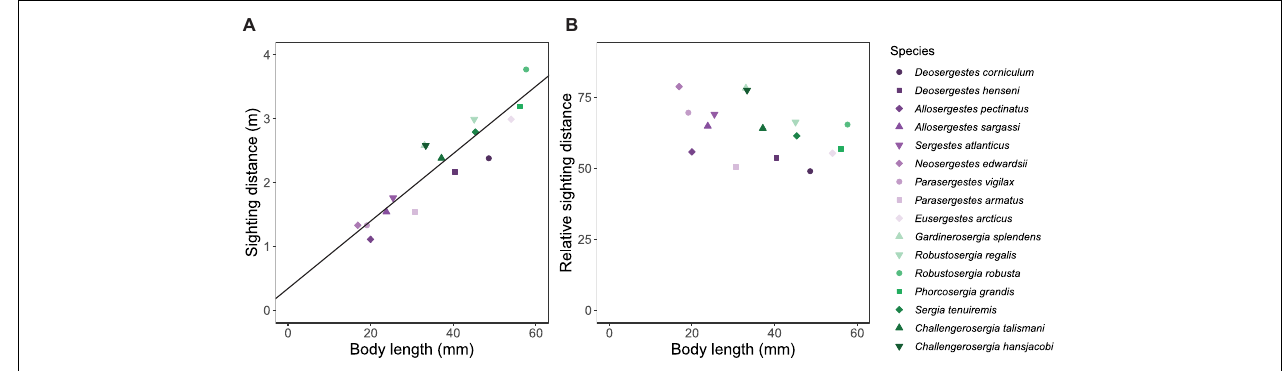
FIGURE 6 | Maximum thresholds of bioluminescence sighting distance. Plots show (A) estimated sighting distance and (B) relative sighting distance (as a factor of body lengths for a given species) vs. mean body length for -sergia (green) and -sergestes (purple) groups of sergestid shrimps. Sighting distances are based on species means for absolute eye size, indicating the maximum distance a sergestid might detect a bioluminescent point source on a black background using an approach originally developed by Nilsson et al. (2014) and then modified by Ruxton and Johnsen (2016). Solid line indicates a significant ordinary least square (OLS) regression (adjusted R 2 = 0.83, p <